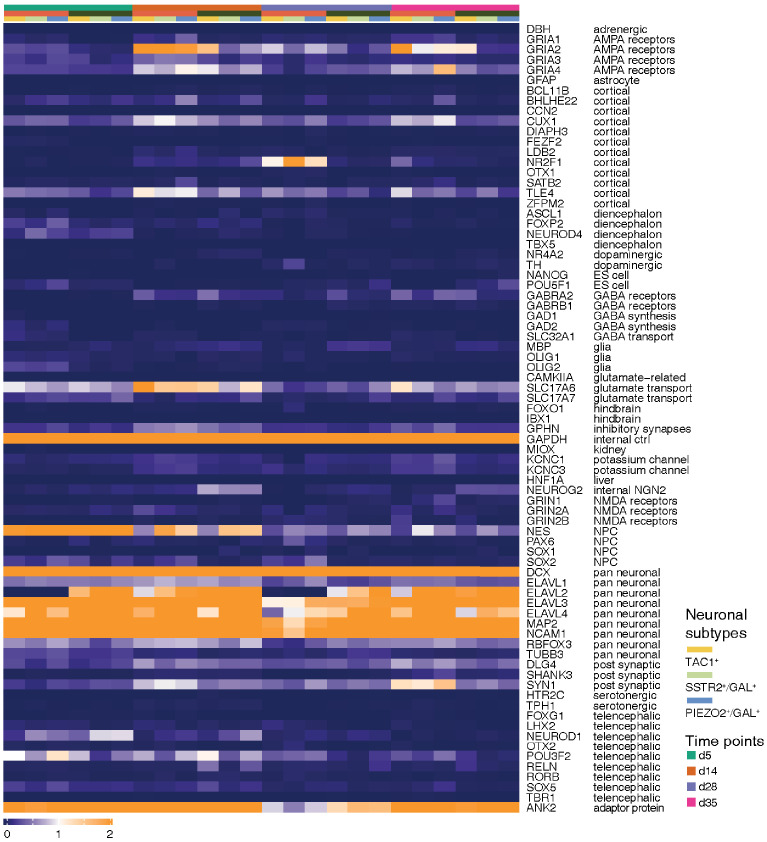
Expression of cortical excitatory neuron genes.Heatmap of mRNA expression of all marker genes found in the single-cell quantitative RT-PCR analysis (Fluidigm) of Zhang et al. We could identify expression of almost all markers in all species and cell lines, with the absence of expression of few genes in our dataset including forebrain marker FOXG1 and GABA receptor GABRB2.